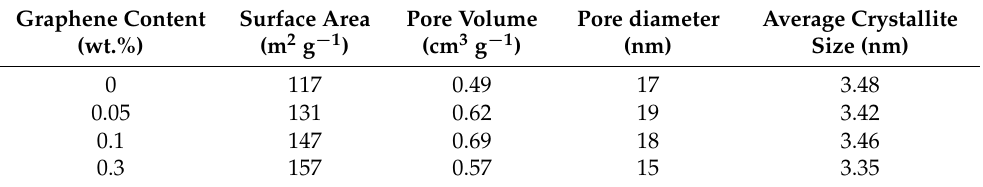
Table 1. Textural properties and crystallite size of pristine SnO 2 aerogel and SnO 2 aerogel/reduced graphene oxide (rGO) nanocomposites with different rGO loadings.